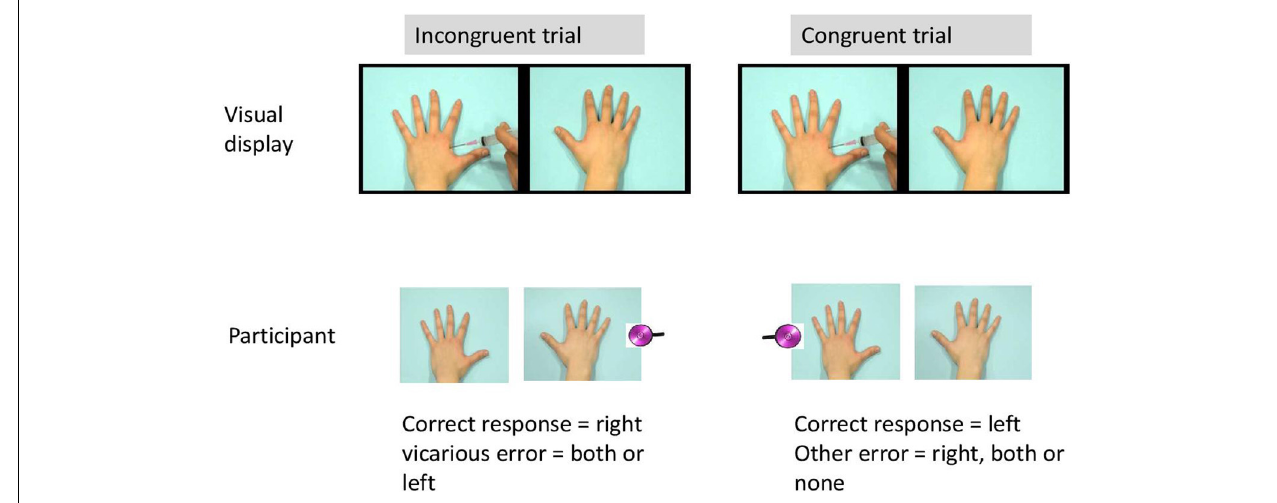
FIGURE 3 | Example of a possible